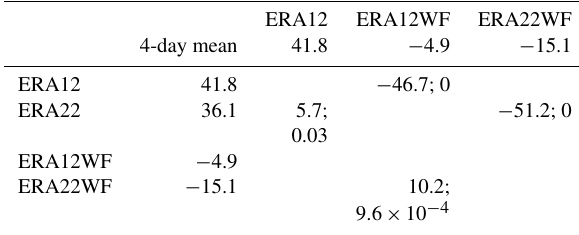
Table 6. Differences (first value) and p values (second value) from two-sample t tests of simulated power from different ERA runs.